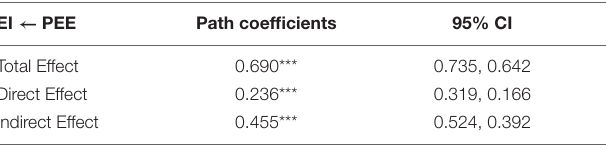
TABLE 6 | The Effect of Post-pandemic Entrepreneurial Environment on Entrepreneurial Intentions. EI ←